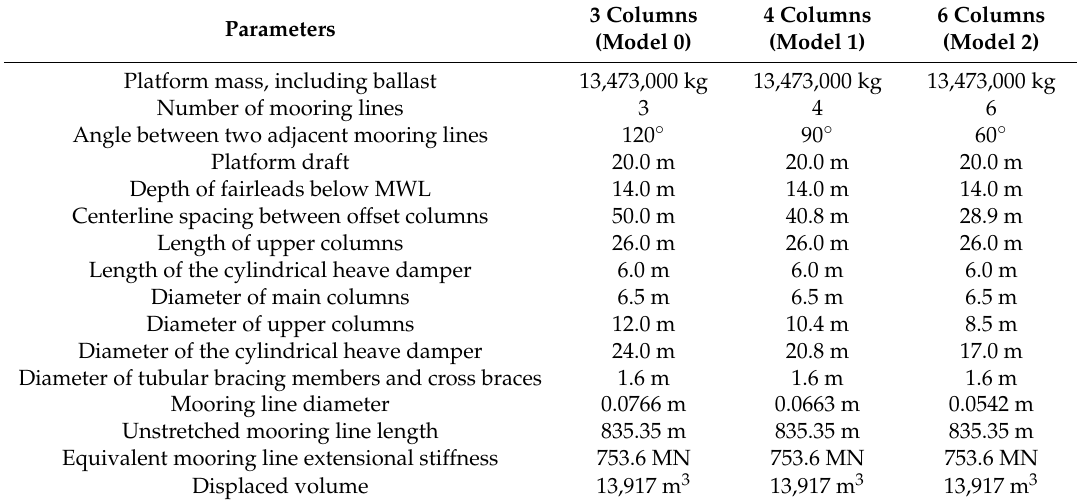
Table 2. Main parameters of the semi-submersible platform and mooring